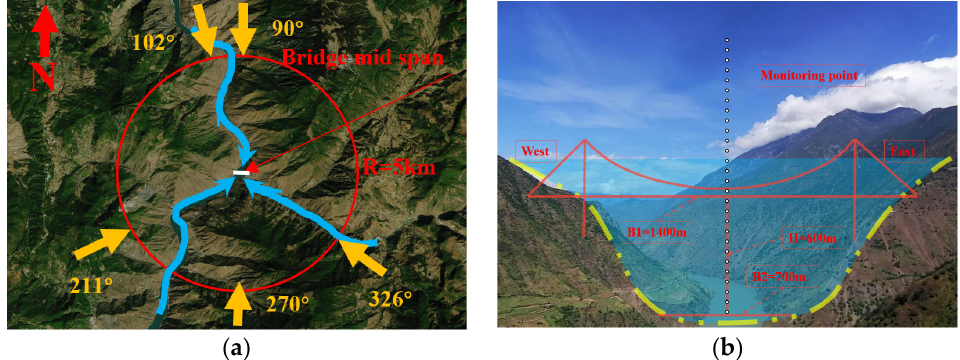
Figure 1. Mesh grid of topographic model. ( a ) Valley terrain features and oncoming wind direction. ( b ) Sketch of bridge arrangement.